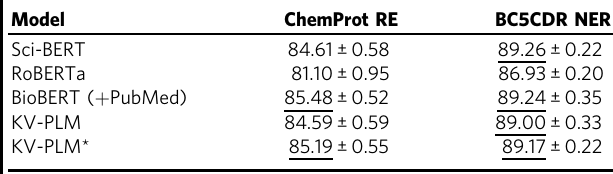
Table 4 Experiment results on ChemProt and